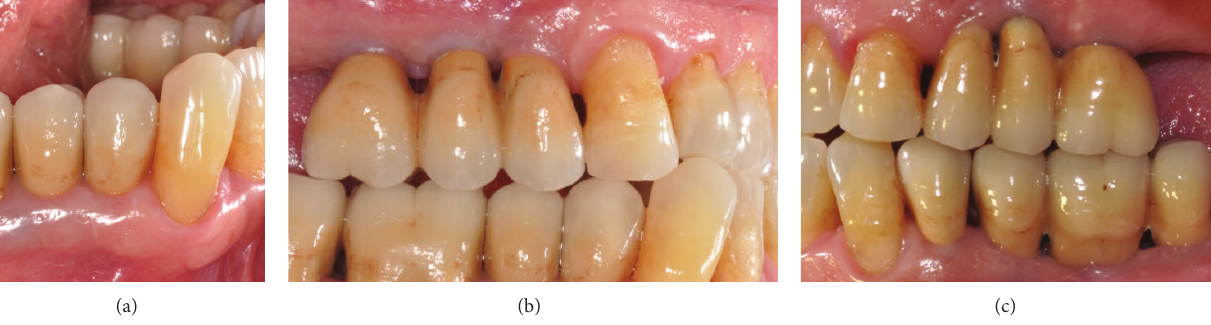
Figure 9: Clinical situation after 1 year from loading time; (a) type 1 implant positioning; (b) type 2 implant positioning; (c) type 3 implant positioning.